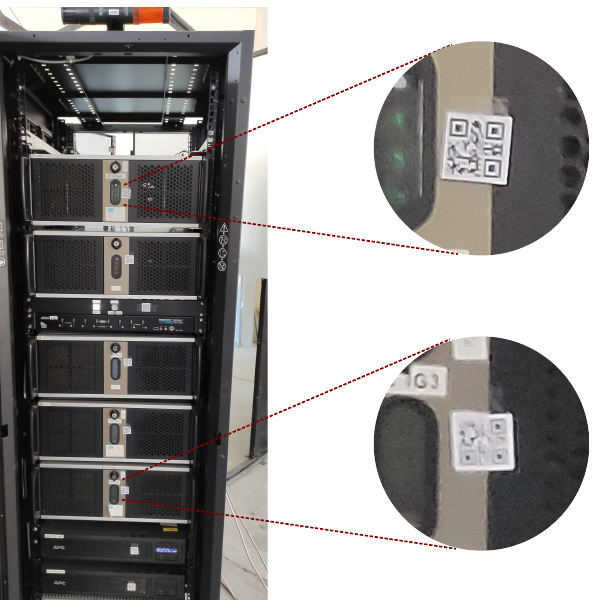
Figure 1. Exemplary situation illustrating small QR codes in inspection of rack with numerous PCs. Picture taken with Microsoft HoloLens 2 front camera at its full photographic